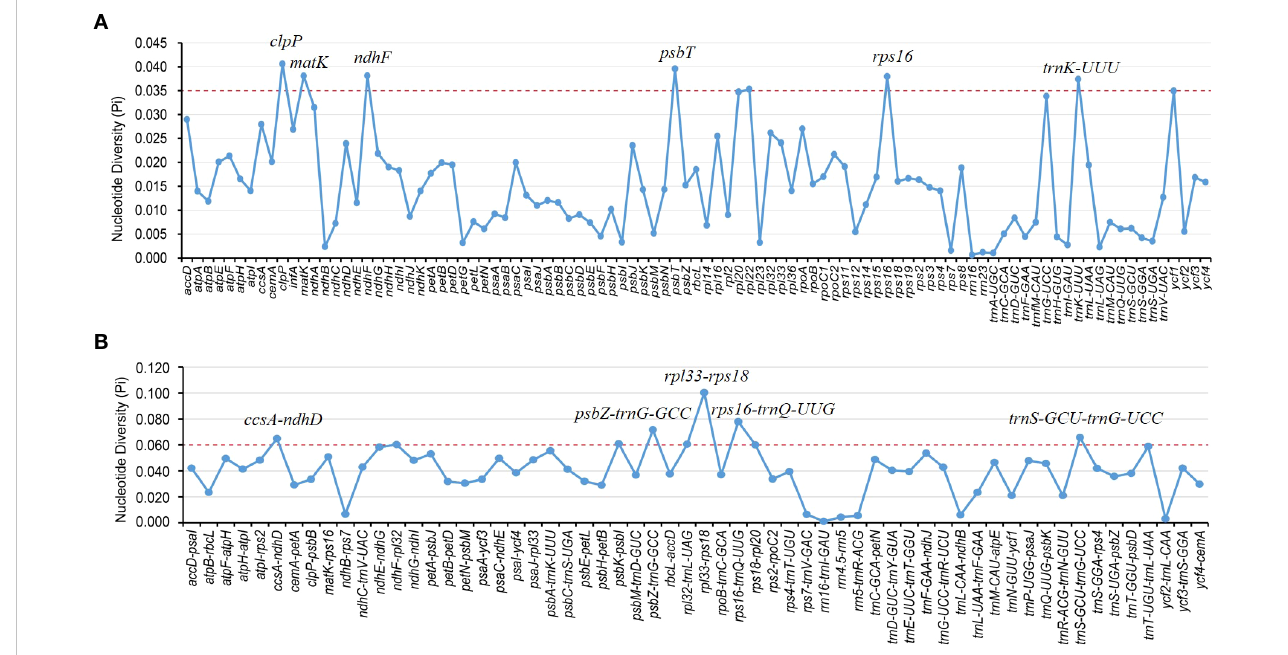
FIGURE 5 Nucleotide diversity (Pi) of shared various regions in 11 Aristolochia species chloroplast genomes. (A) Pi values in the genes regions. (B) Pi values in the intergenic spacers regions.